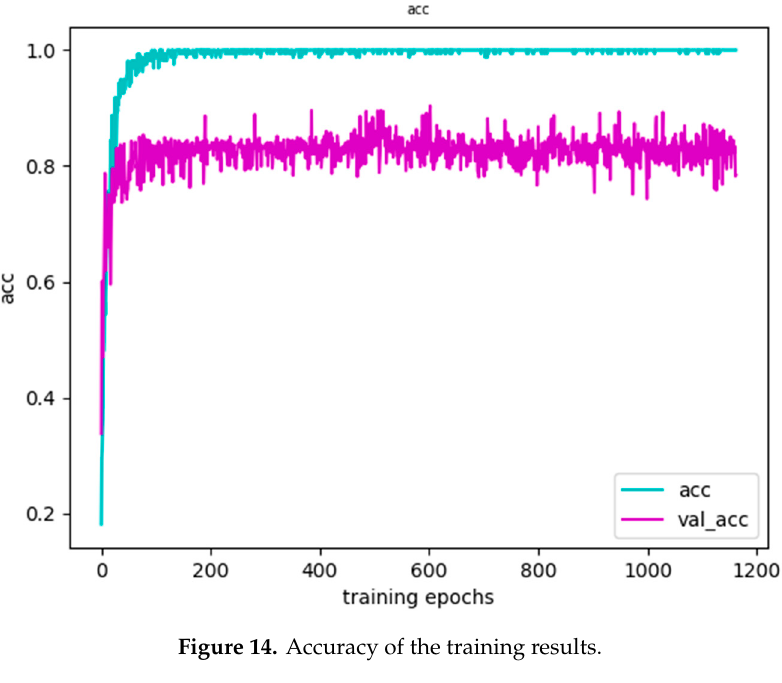
Figure 14. Accuracy of the training results.